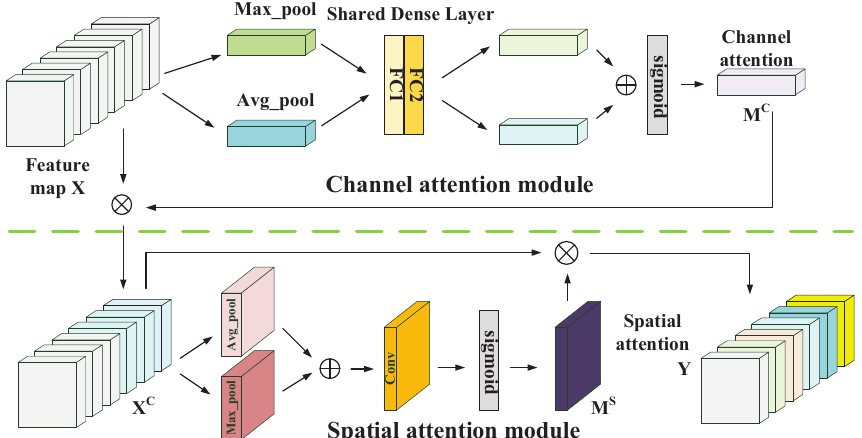
Figure 2. The detailed structure of channel and spatial attention module. (Top) Channel-wise attention module. (Bottom) Spatial-wise attention